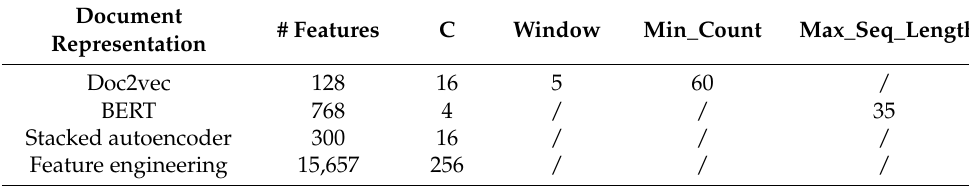
Table 2. Some parameters for various document representations.